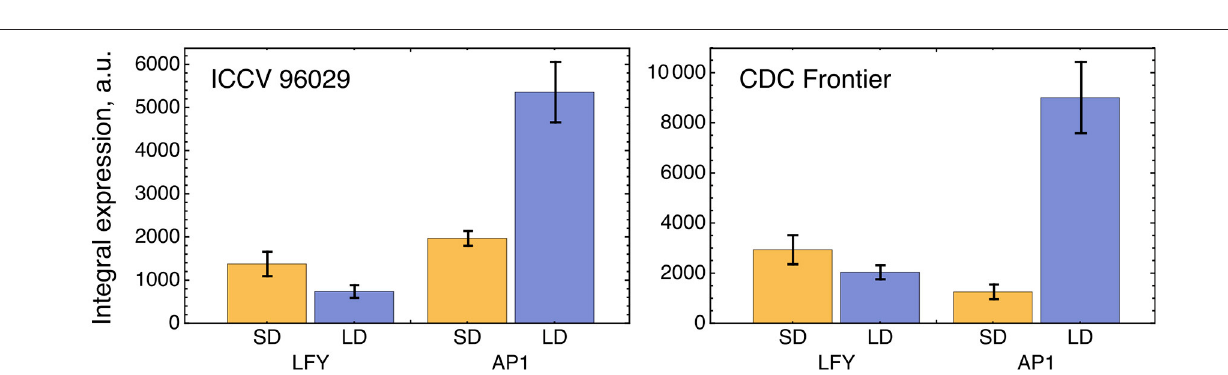
Frontiers in Genetics |